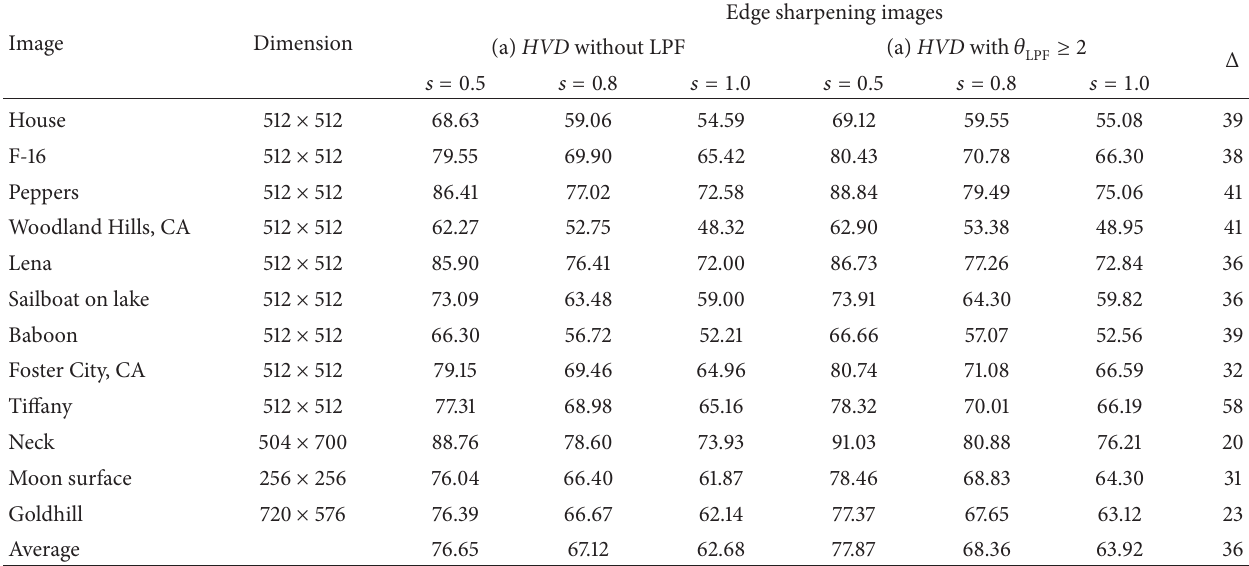
Table 1: Comparisons of the sharpened images with respect to original images in terms of PSNR.